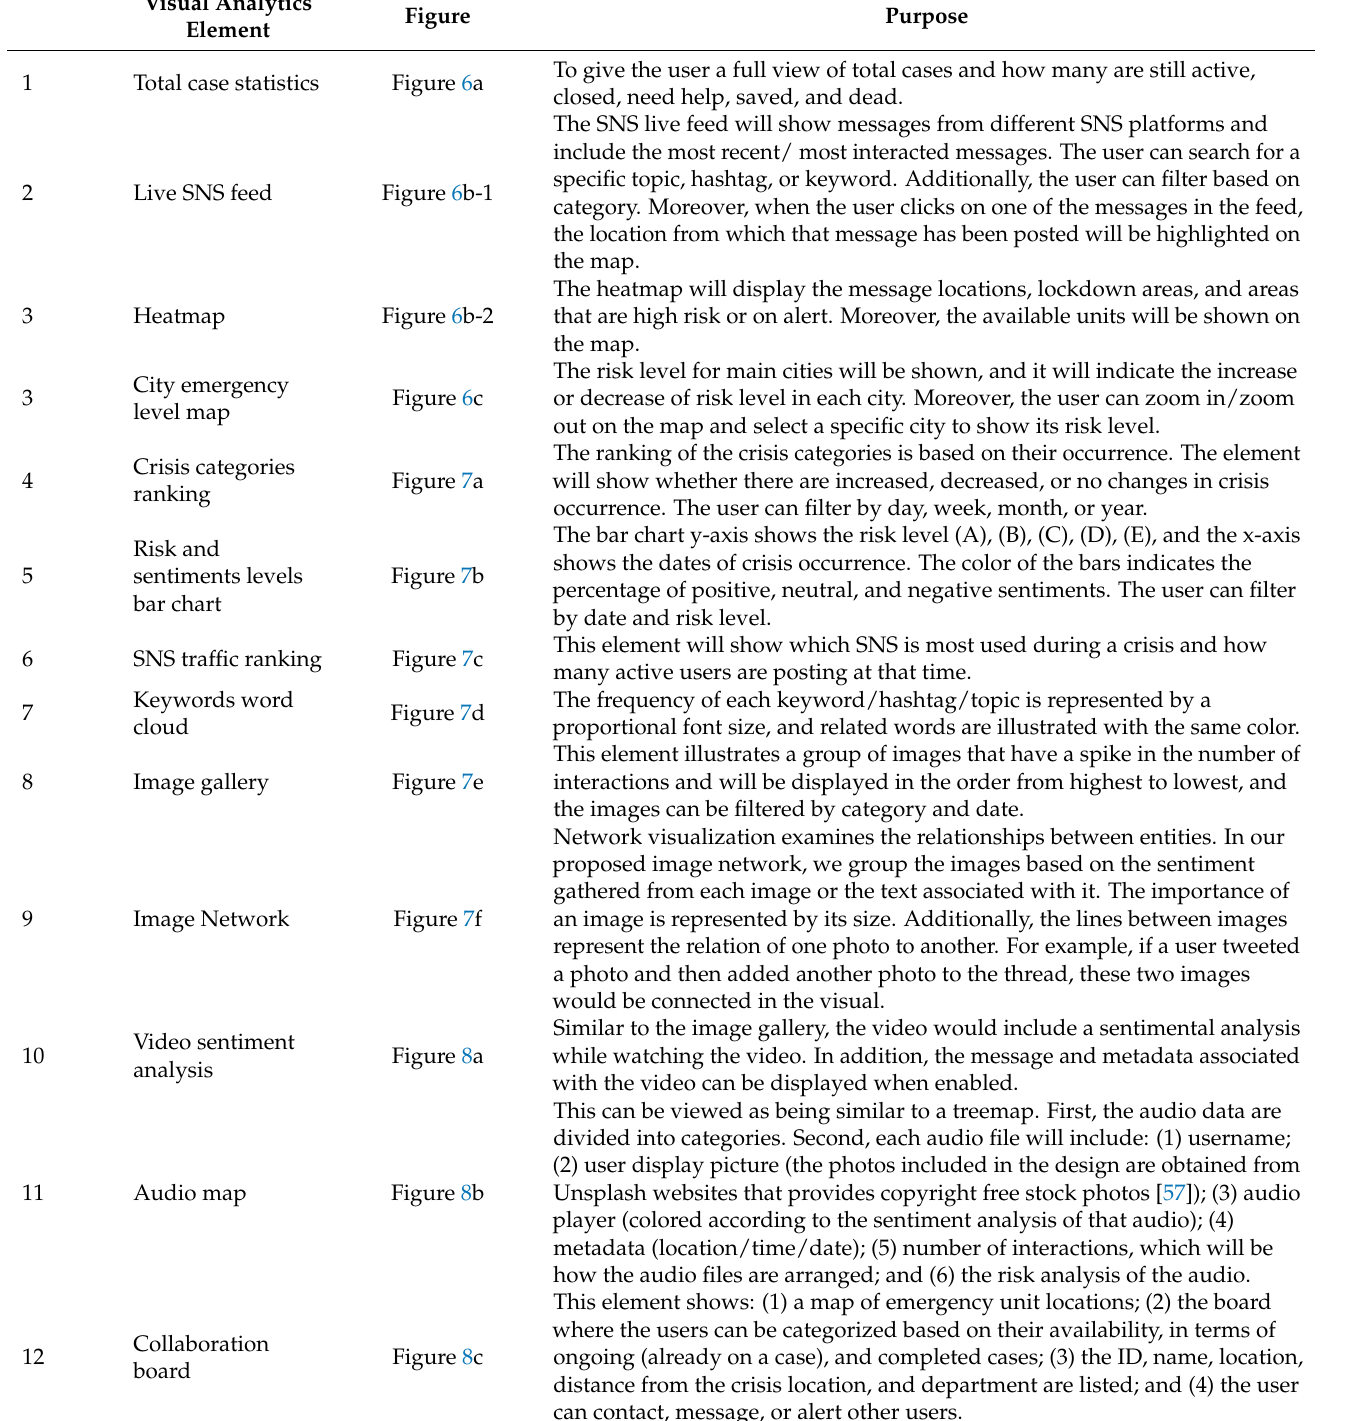
Table 3. Multi-monitor visual analytic elements of multimodal